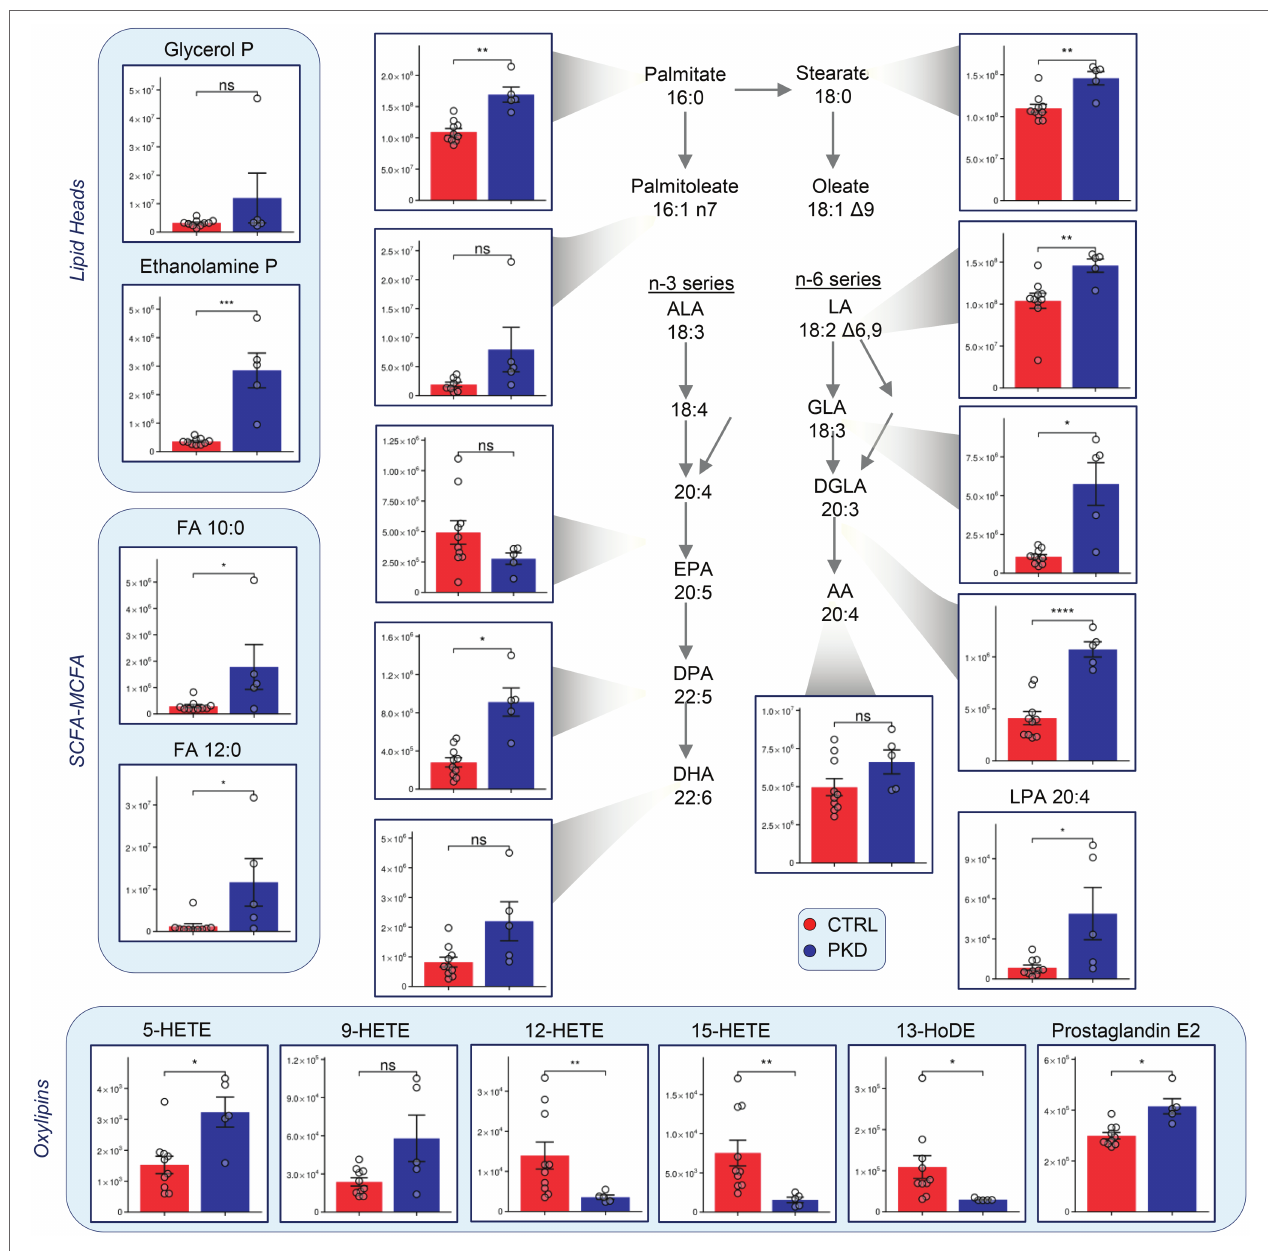
FIGURE 5 | Pyruvate kinase deficiency reprograms fatty acid metabolism when compared with controls. Y-axes represent peak area (arbitrary units). Asterisks indicate significant results, error bars represent ±SEM (unpaired t -test, two-tailed distribution, * p < 0.05, ** p < 0.01, *** p < 0.001, and **** p <